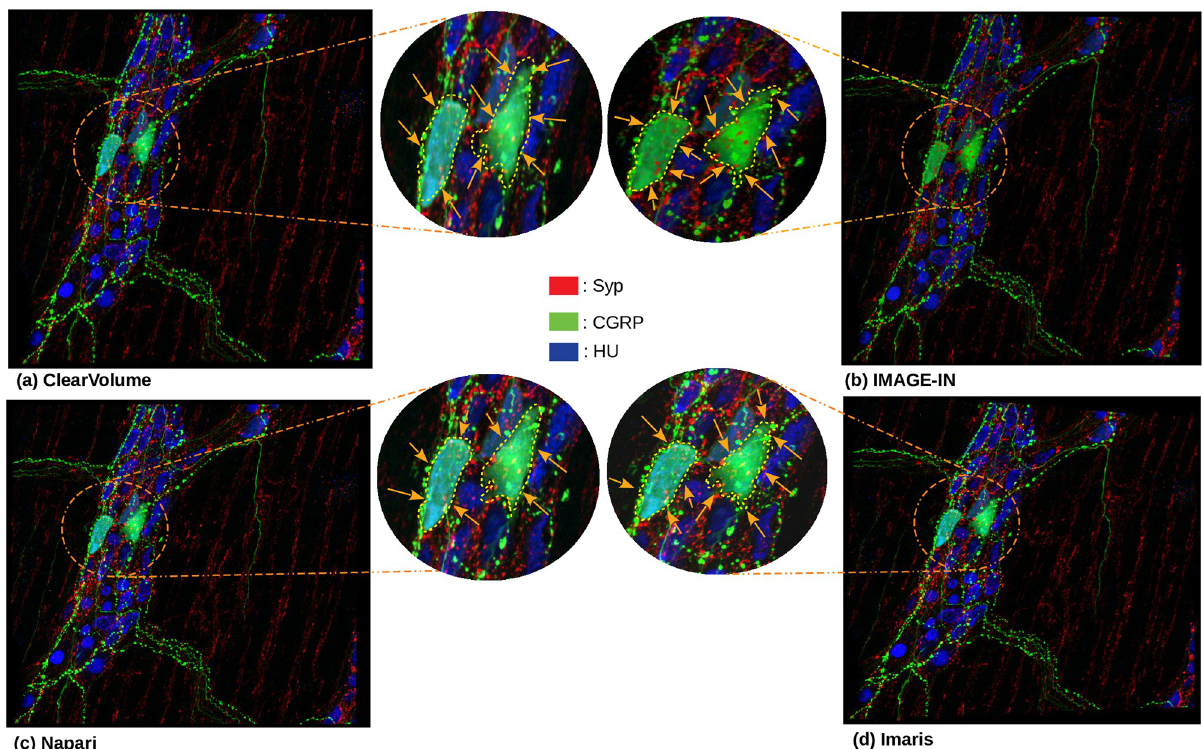
Fig 9. The three-channel mouse proximal colon [44] CLSM dataset is rendered in 3D volume on the following viewers: (a) Clearvolume (the ImageJ open-source desktop viewer), (b) IMAGE-IN (the web visualizer), (c) Napari (the Python desktop visualizer), and (d) Imaris (the closed-source desktop viewer). The orange arrow on each rendered image indicates the variation in region across four viewers. When compared to the other three viewers, the IMAGE-IN viewer clearly reveals more Syp (represented by the red color) and HU (represented by the blue color) on this specific spot. This comparison is made in the early